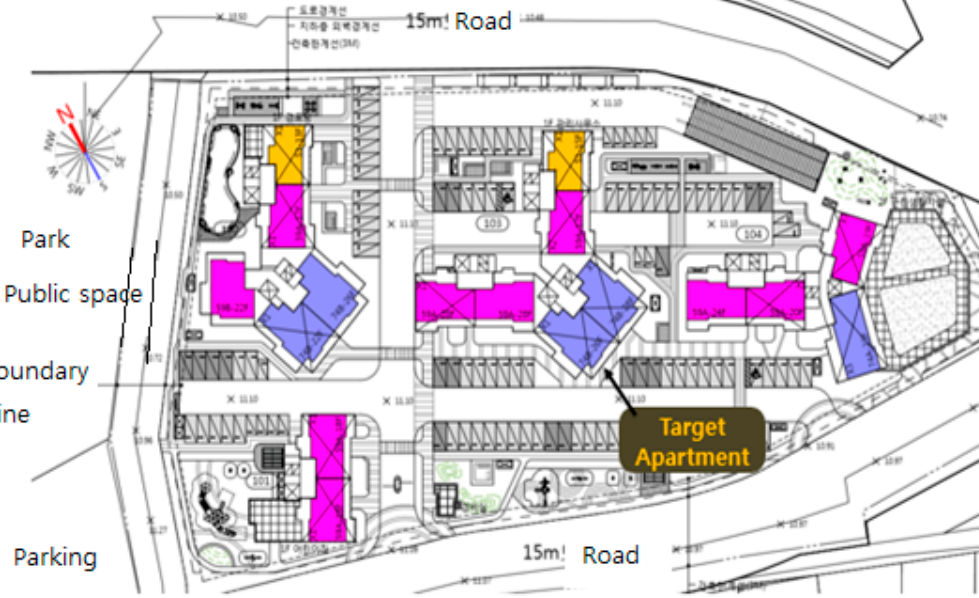
Figure 2. The site plan for the target apartment. Figure 3 shows the perspective view of the target apartment and total block.